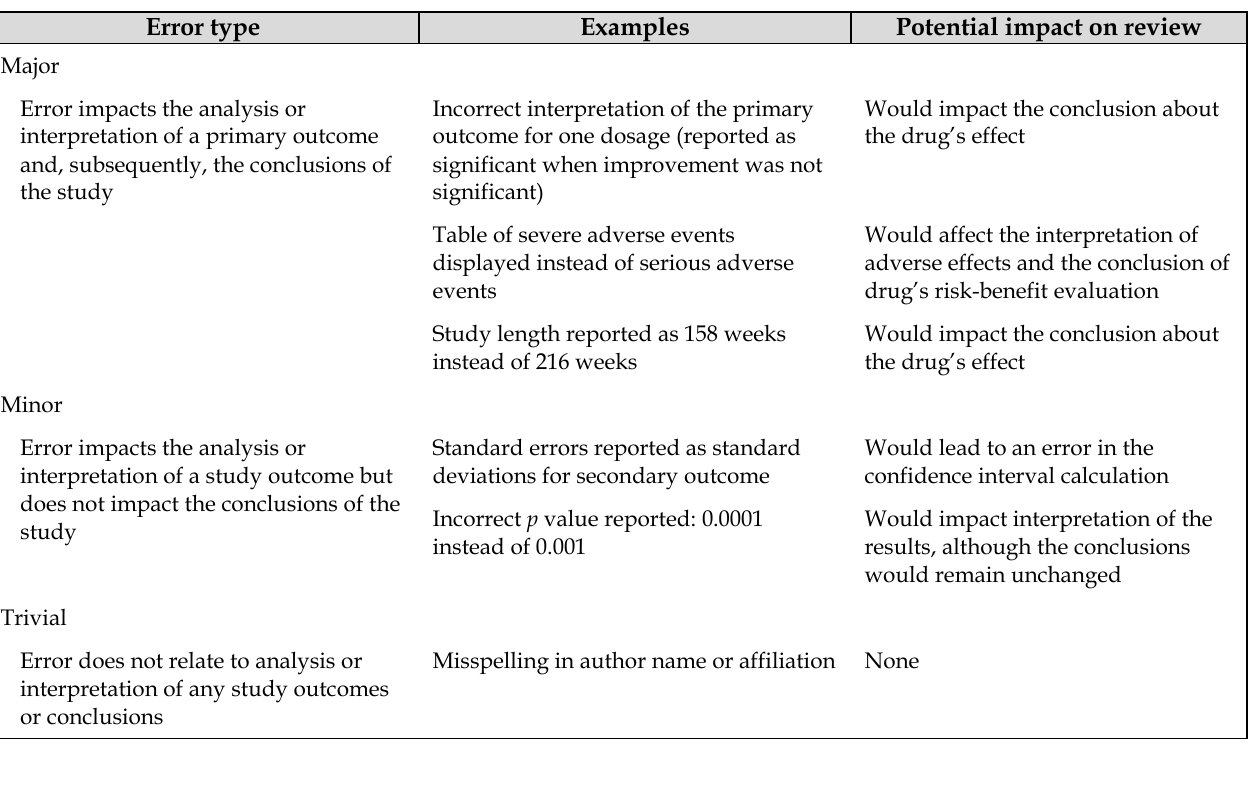
Table 1 Types of errors found and their impact on interpreting study results